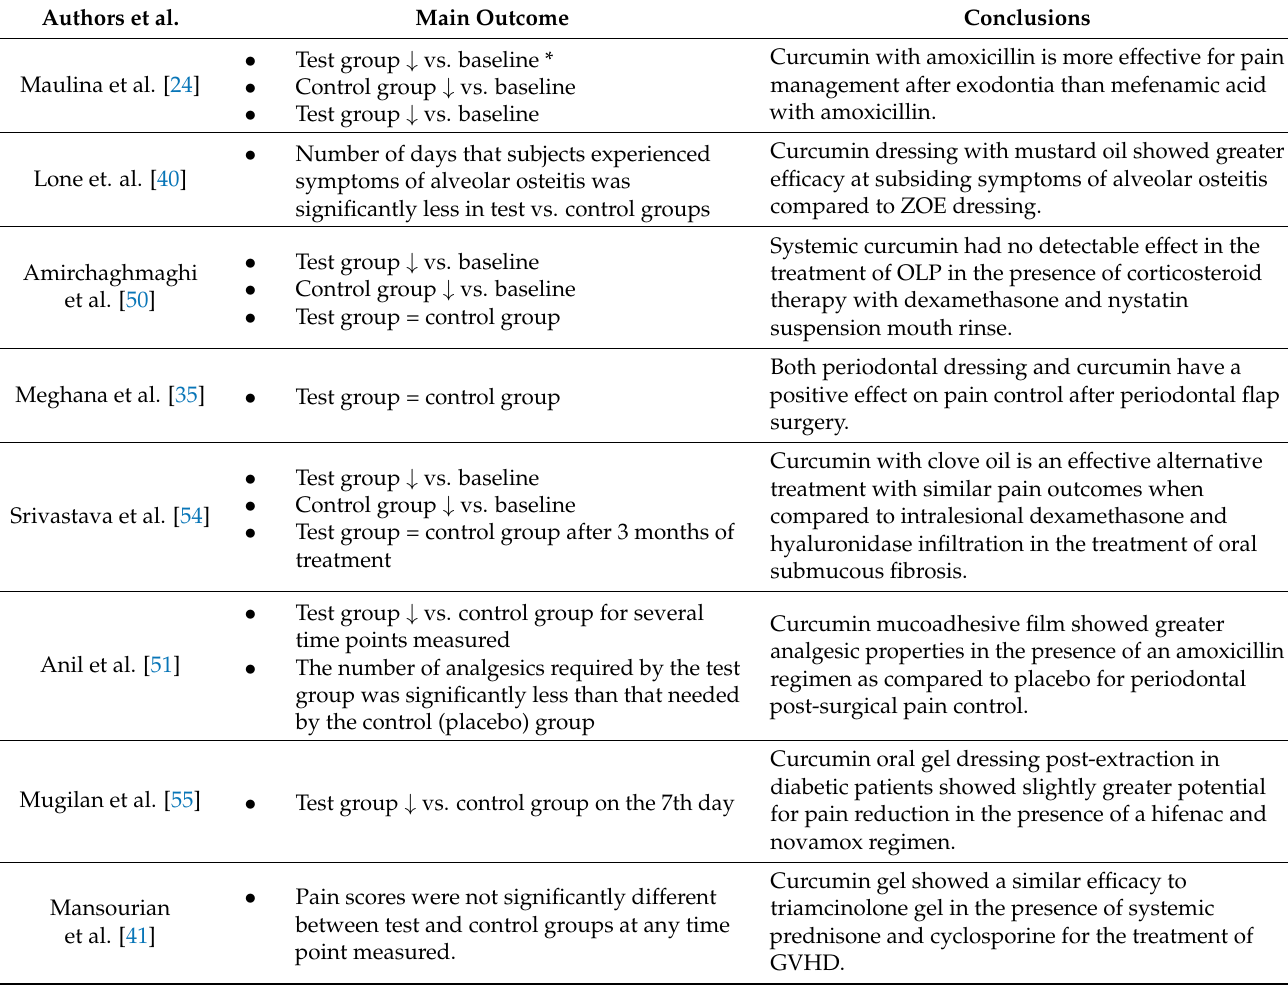
Table 5. Main outcomes and conclusions of studies with curcumin-combination-treated study